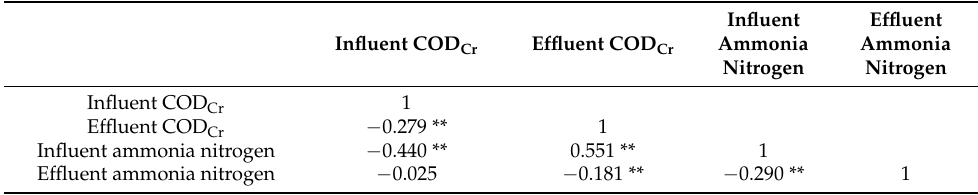
Table 2. Pearson correlation analysis of various indicators of influent and effluent of the sewage treatment